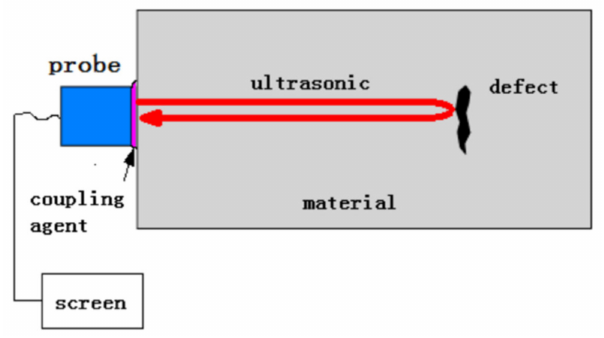
Figure 1. Basic principle of ultrasonic testing